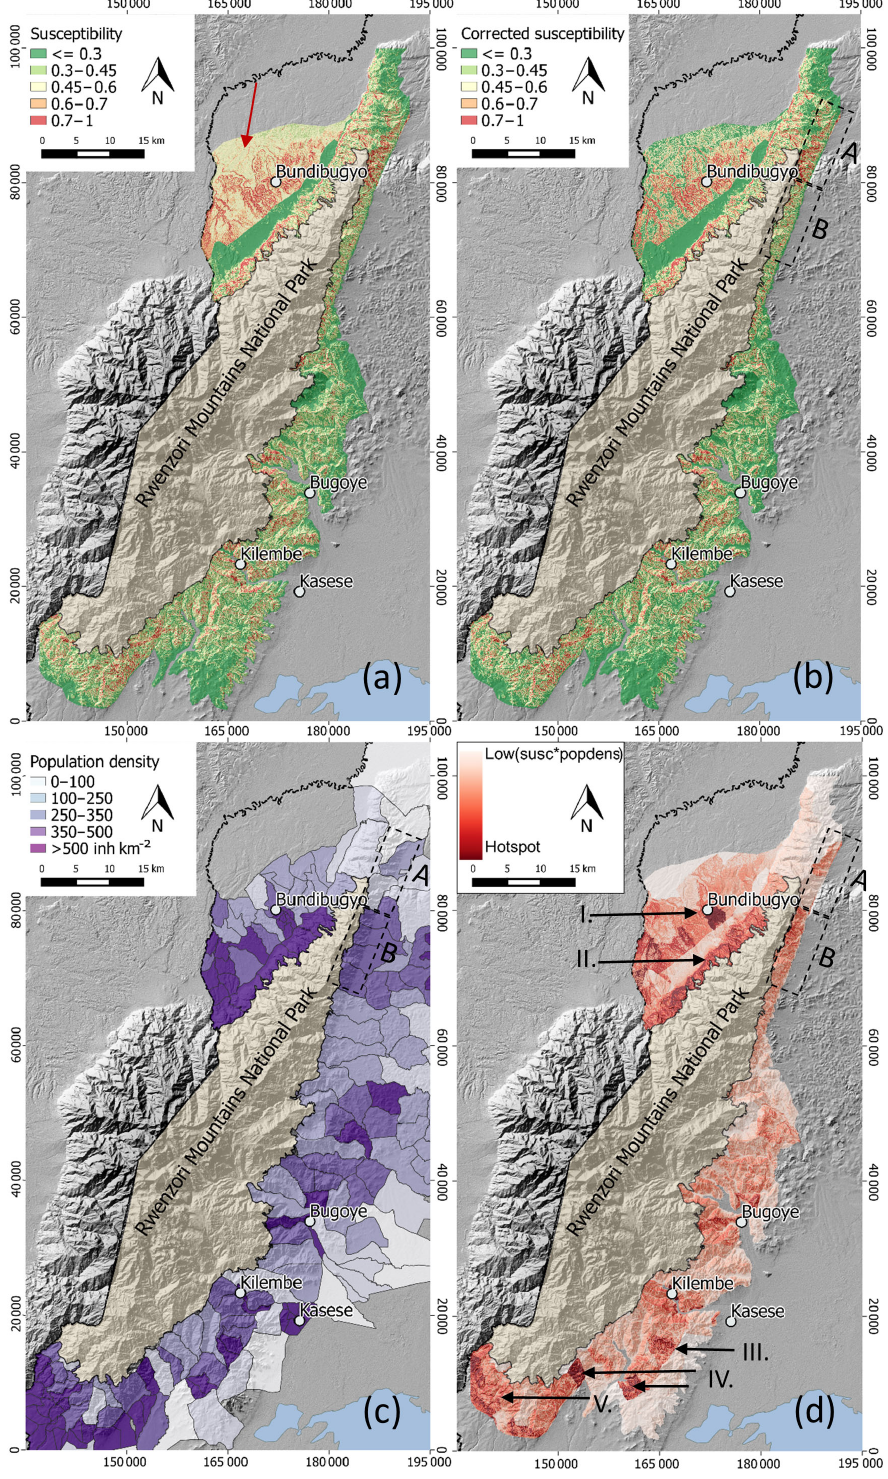
Figure 5. Landslide susceptibility (susc) and population density (pop dens) distribution in the Rwenzori Mountains’ inhabited zone. (a) Landslide susceptibility (red arrow indicates artefacts in regional landslide susceptibility model). (b) Corrected landslide susceptibility. (c) Population density at parish level (source: UBOS, 2003). (d) Preliminary identification of landslide hotspots. A and B indicate polygons discussed in the text. I to V indicate particular hotspot locations elaborated in the